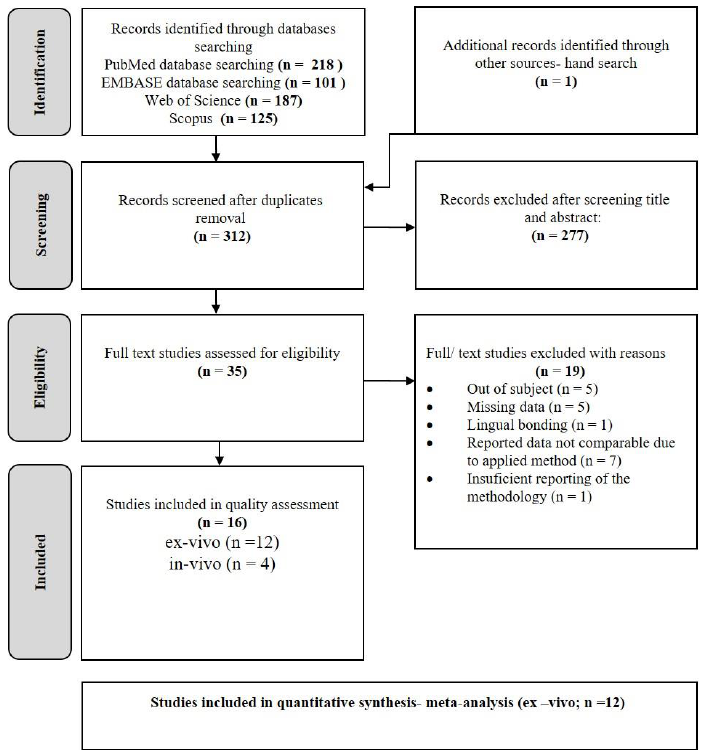
Figure 1. Flow diagram of information through the different phases of a systematic review according to Preferred Reporting Items for Systematic Reviews and Meta-Analyses (study selection process).